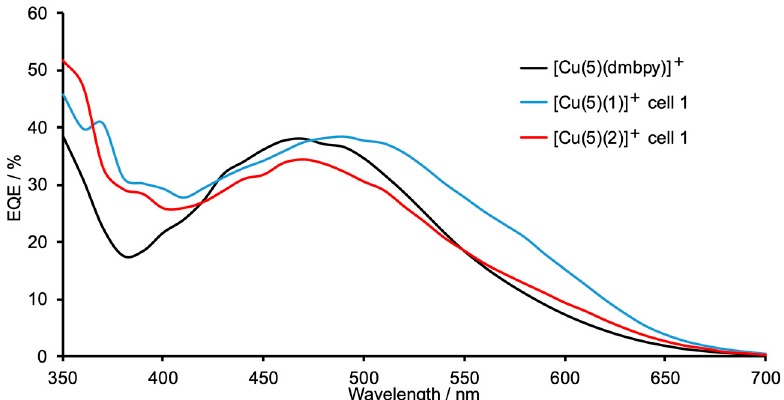
Figure 9. A comparison of the EQE spectra for DSCs sensitized with [Cu( 5 )( 1 )] + (blue curve), [Cu( 5 )( 2 )] + (red curve) and [Cu( 5 )(dmbpy)] + (black curve, data from ref [57]), measured on the day of sealing the cells.